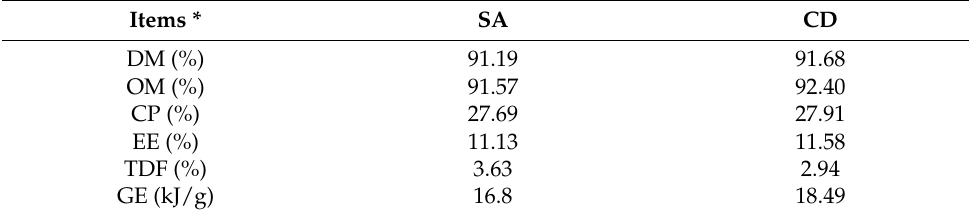
Table 1. The chemical and energy compositions of SA and CD diets.